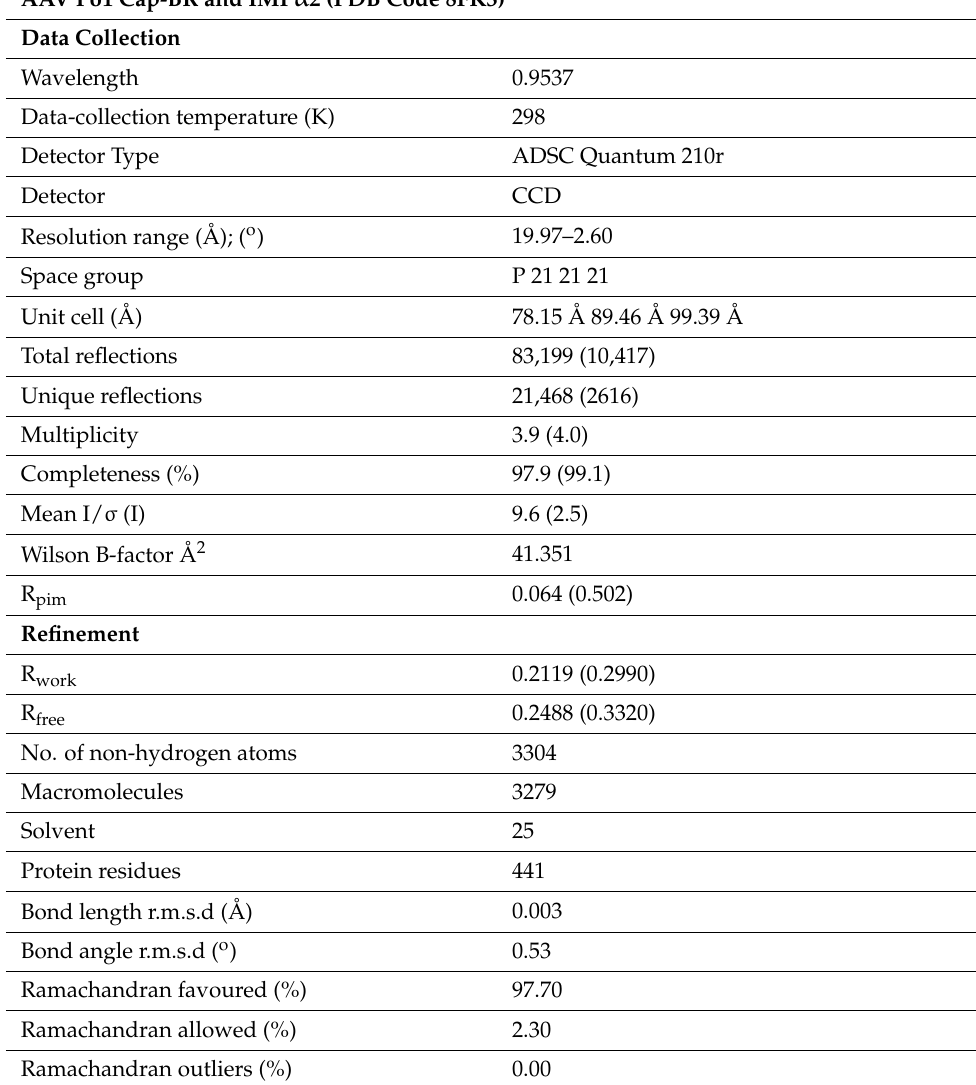
Table 1. Data collection and refinement statistics for the structure of importin- α in complex with AAV Po1 basic regions